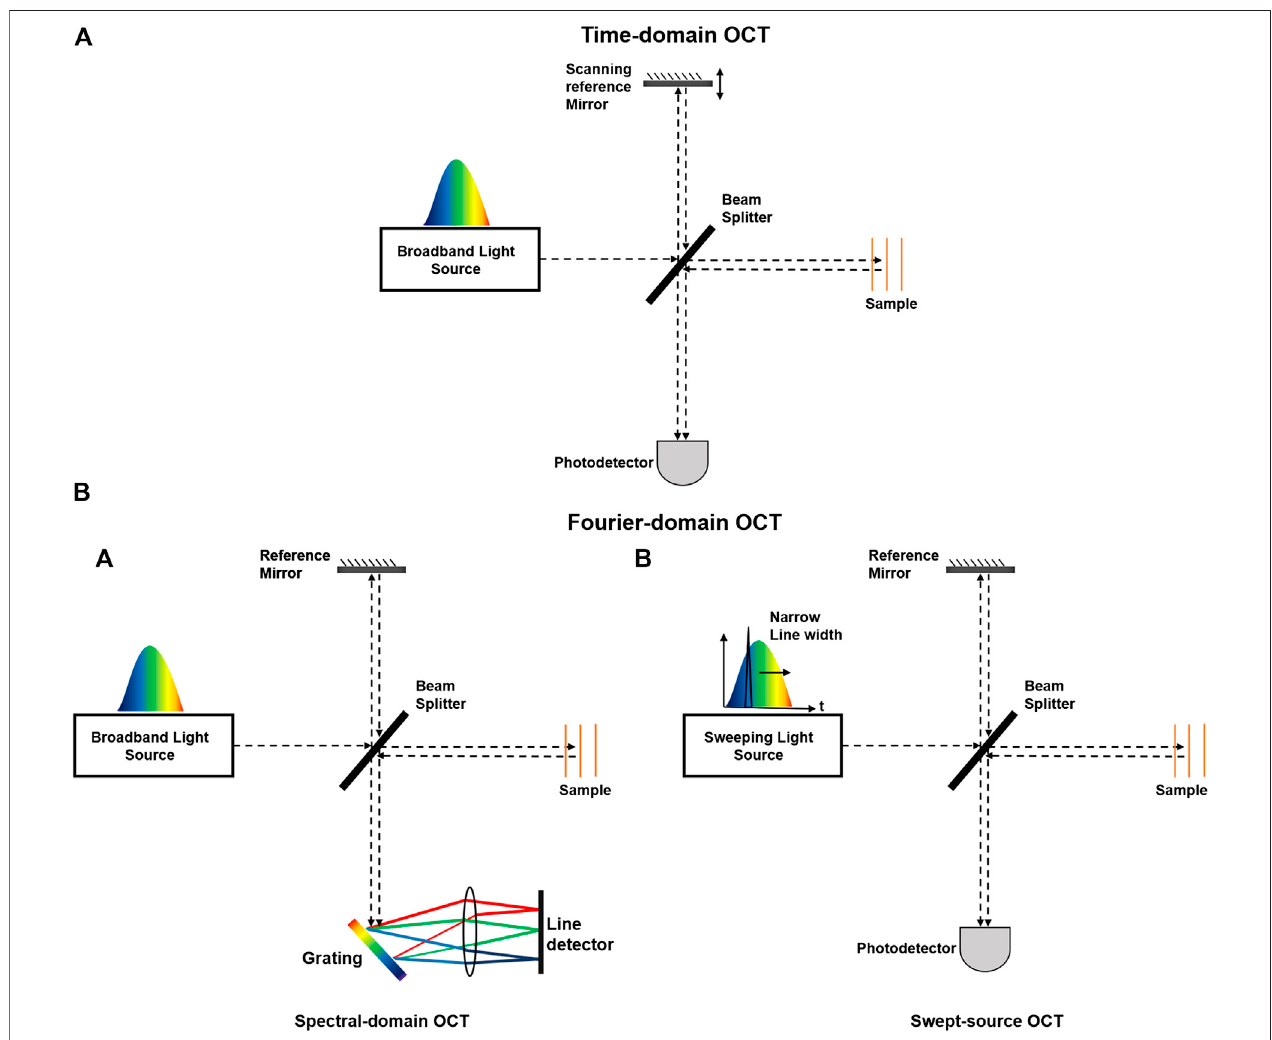
FIGURE2| SchematicofdifferentOCTmodalities.OCTsystemscanbeclassi fi edinto (A) timedomain(TD)and (B) Fourierdomain(FD)systems.FD-OCTsystems can be further divided into (A) spectrometer-based and (B) swept source-based systems.